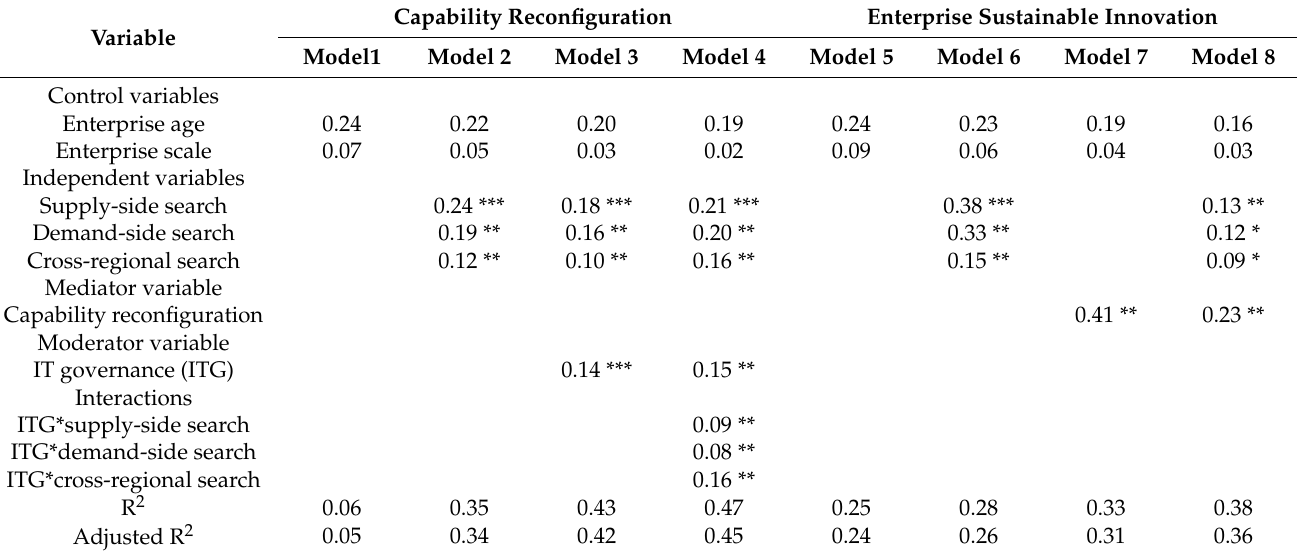
Table 5. Model hierarchical regression